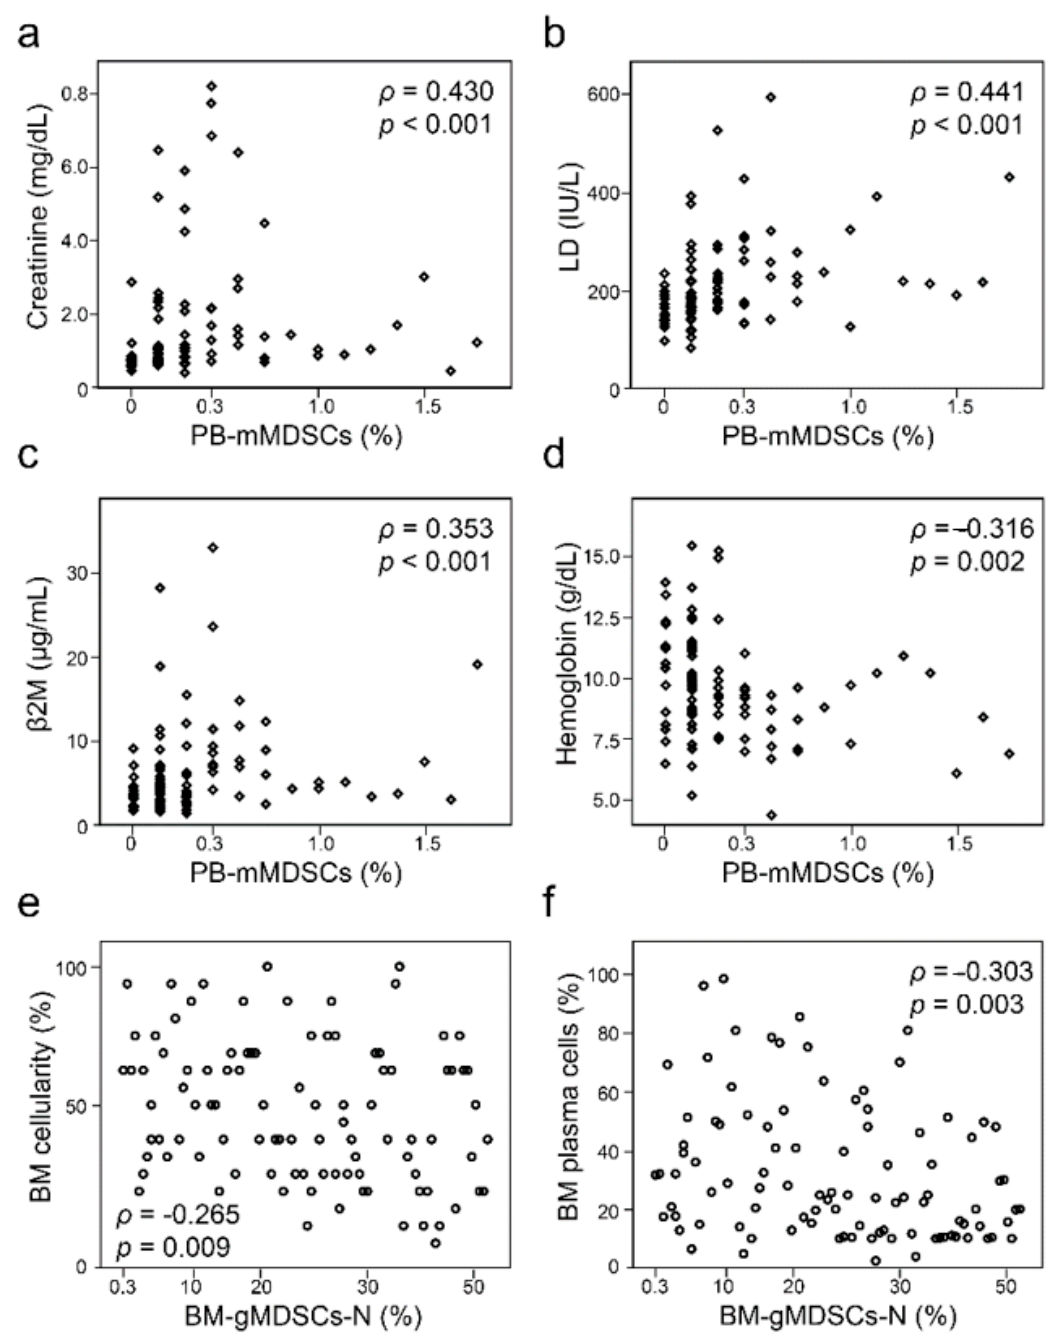
Figure 2. Scatter plots with significant correlation between laboratory measurements and myeloid-derived suppressor cells of 97 patients with plasma cell myeloma. Peripheral blood monocytic MDSCs show correlation with serum creatinine, lactate dehydrogenase, and β 2-microglobulin ( a – c ) and inverse correlation with hemoglobin level ( d ). Bone marrow granulocytic MDSCs with neutrophils inversely correlate with bone marrow cellularity and plasma cells ( e , f ). Abbreviations: Cr, creatinine; LD, lactate dehydrogenase; β 2M, β 2-microglobulin; PB-mMDSCs, peripheral blood monocytic myeloid-derived suppressor cells; BM-gMDSCs-N, bone marrow granulocytic myeloid-derived suppressor cells with neutrophils.